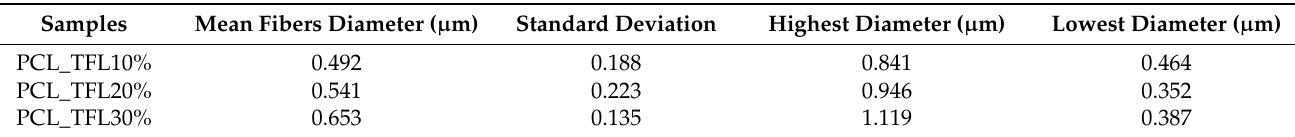
Table 7. Mean fibers’ diameter ( µ m), standard deviation, highest and lowest diameter ( µ m) value for drug-loaded fibers.